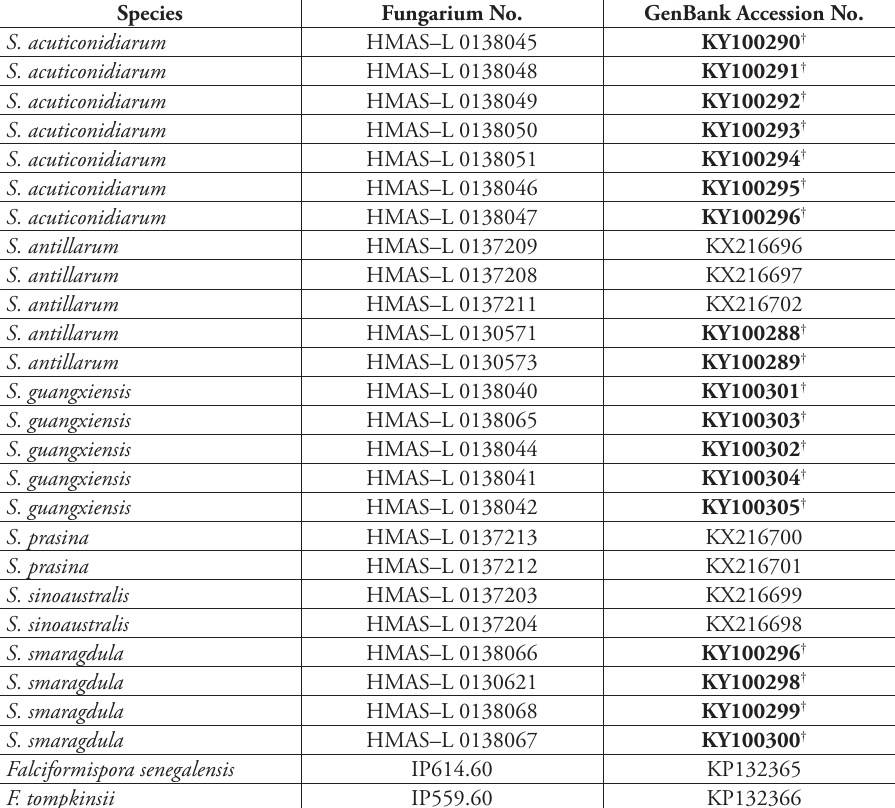
Table 1. Specimens of Strigula spp. from China and outgroup species used in the phylogenetic analyses. Species Fungarium